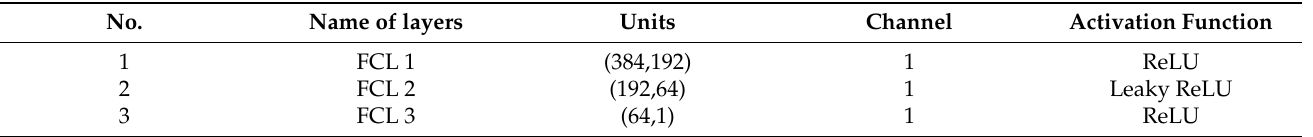
Table 5. Parameters of RUL prediction